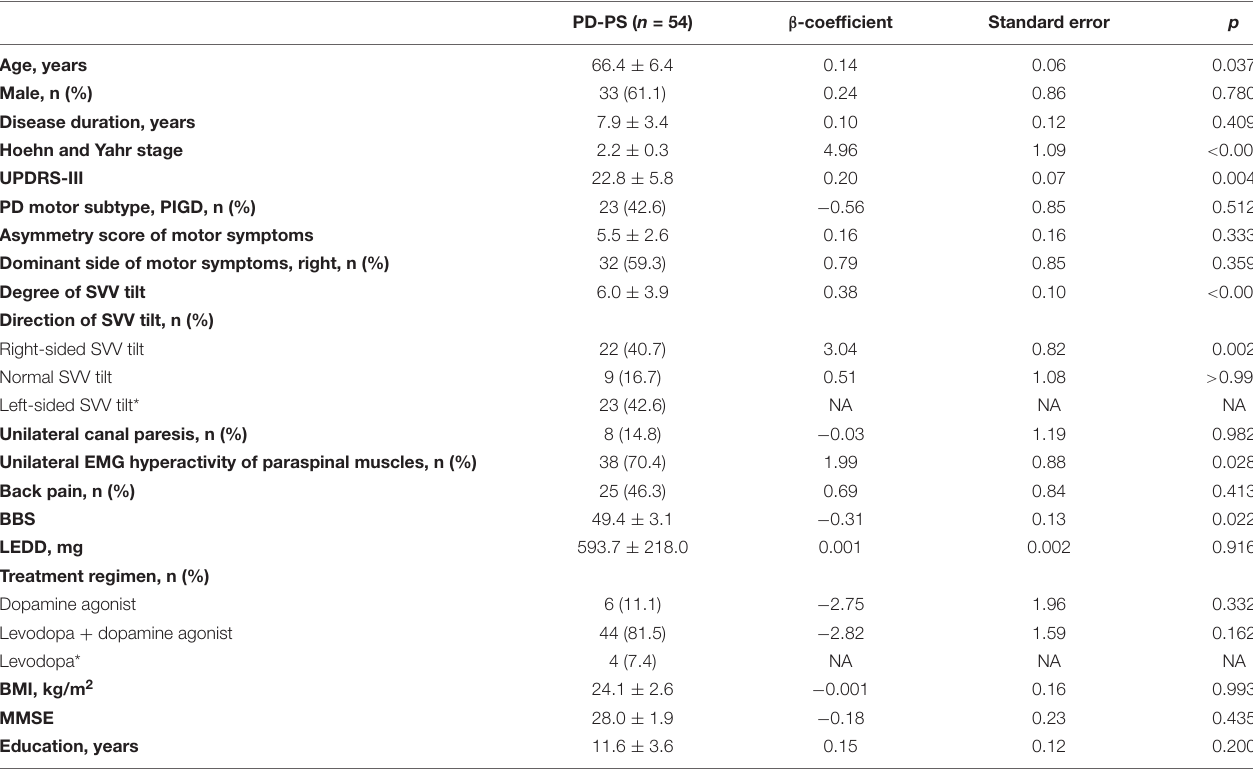
TABLE 1 | Univariable analysis of clinical factors associated with the severity of Pisa syndrome (PS) in patients with Parkinson’s disease (PD). PD-PS ( n = 54) β -coefficient Standard